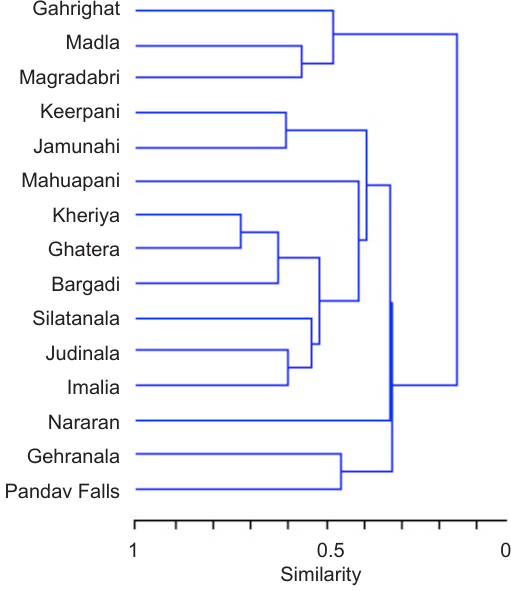
Figure 2. Dendrogram resulting from Bray-Curtis similarities of species abundance data of study